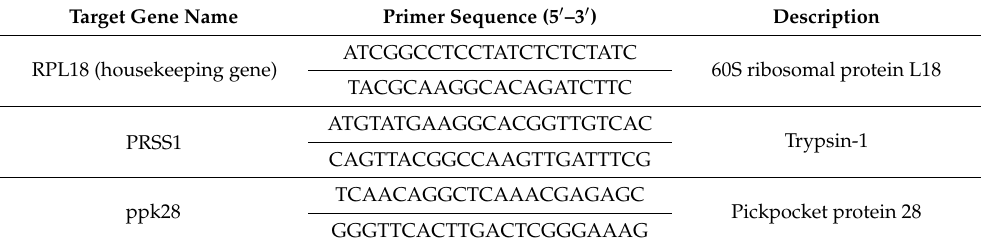
Table 1. Primer sets of qRT-PCR used in the